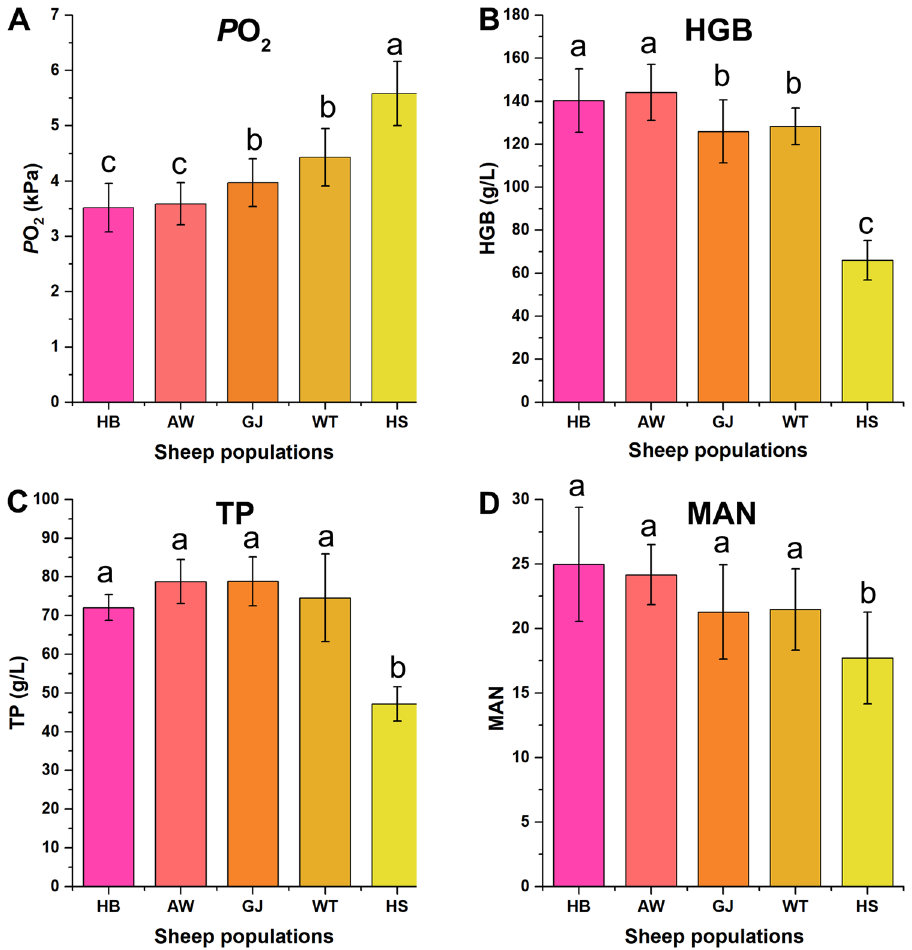
Figure 1. The physiological and biochemical indices of five sheep populations from different altitude. ( A ) Partial pressure of carbon dioxide ( P O 2 ). ( B ) Haemoglobin contents (HGB). ( C ) Total protein (TP). ( D ) The number of alveolar counted per unit area (MAN). The columns with different letters are significantly different at P <